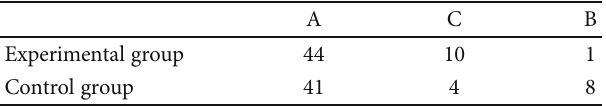
Table 6: The tympanic negative pressure of both ears after 3 months of treatment.